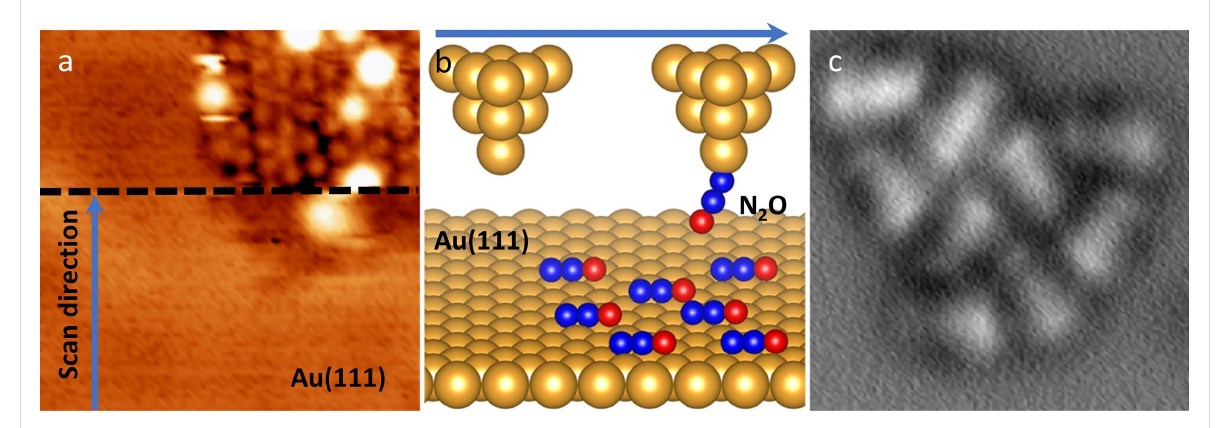
Figure 2: Tip functionalization with a N 2 O molecule. (a) STM image (100 mV, 10 pA, 6 × 6 nm 2 ) demonstrating a spontaneous enhancement of the resolution while scanning over the N 2 O-covered surface. (b) Schematic representation of the functionalization process (blue arrow indicates the scan direction). (c) Constant-height AFM image (2 × 2 nm 2 ) of a single N 2 O cluster obtained with a N 2 O-functionalized tip.